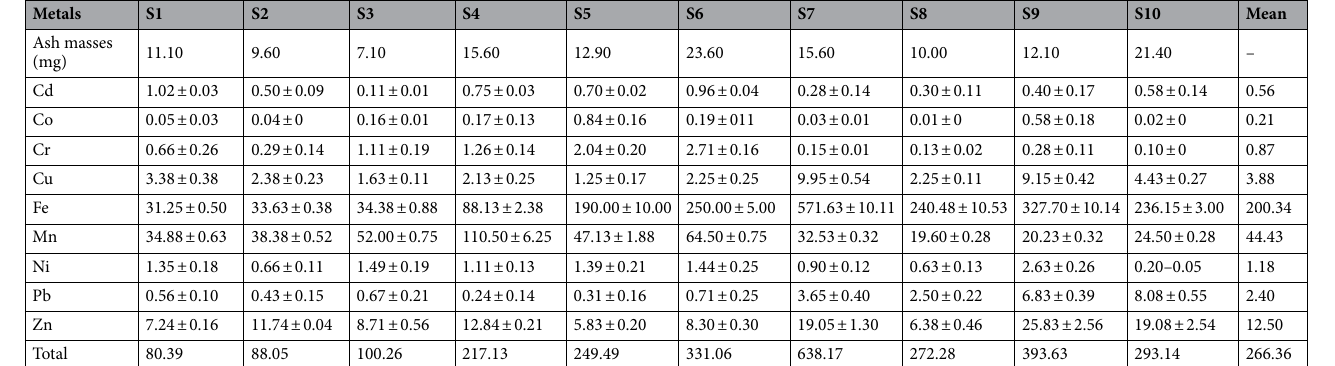
Table 2. Heavy metal concentrations (mg kg −1 d.w.) in the wood pellet